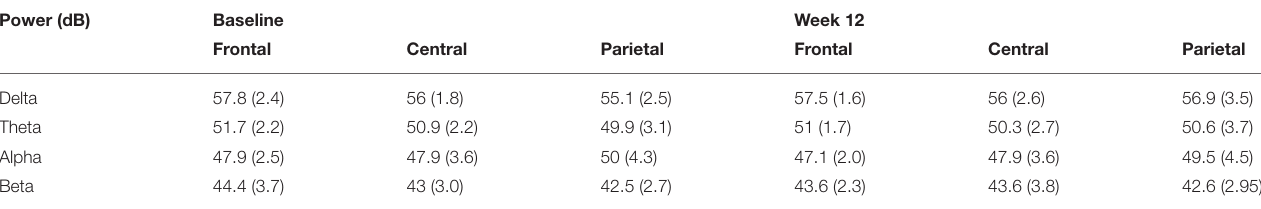
TABLE 3 | Resting EEG power at baseline and week 12 at midline clusters.